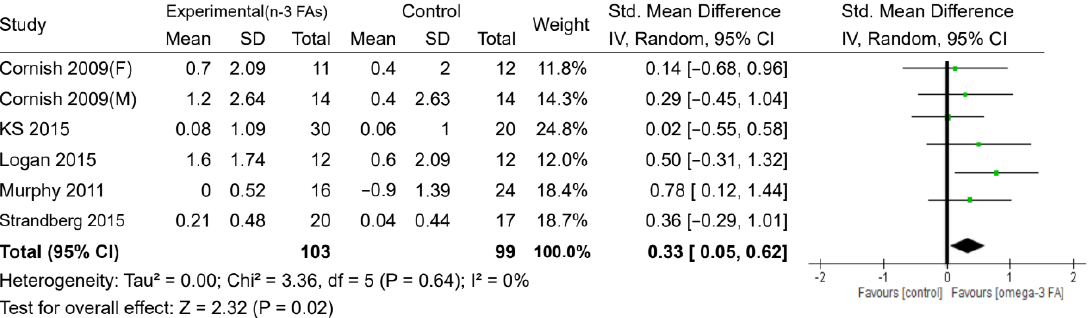
Figure 4. Forest plot of the effect of n-3 PUFA supplementation on muscle mass. IV: inverse-variance method. Random: random effect. Weight (in %), the influence of an individual study on the pooled result.